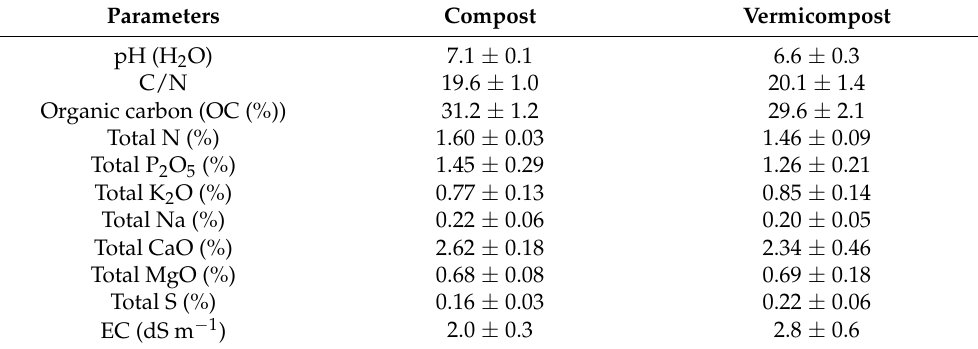
Table 2. Main chemical properties of compost and vermicompost made from the same constituents (cow dung and coconut fiber mix in the ratio 2:1 by volume) and used in the